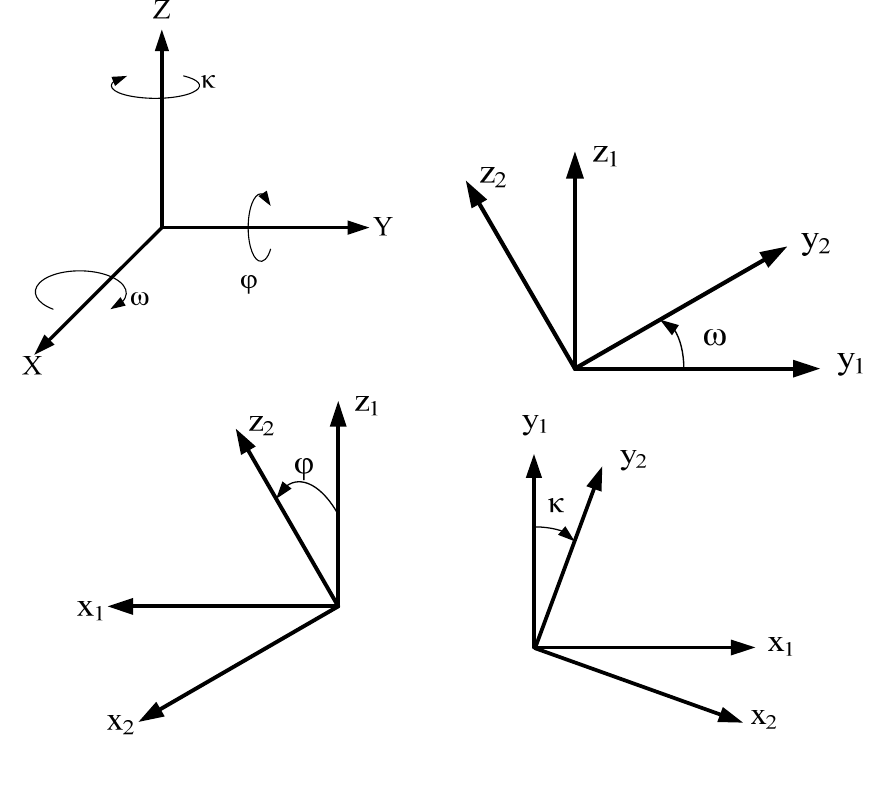
Figure 1. The rotation model on X, Y and Z coordinate